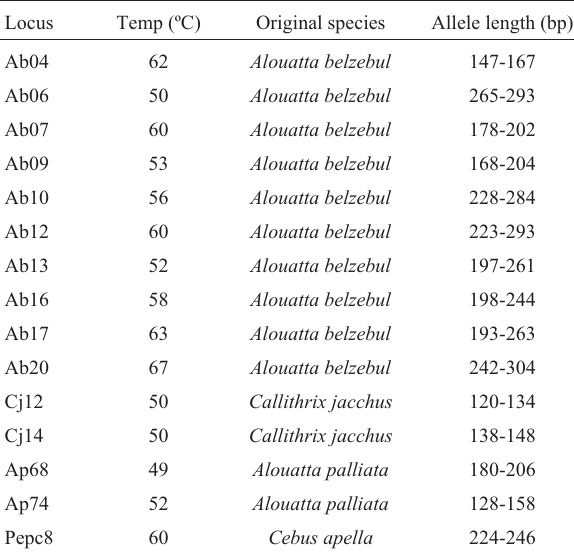
Table 1 - The 15 microsatellite loci analyzed in this